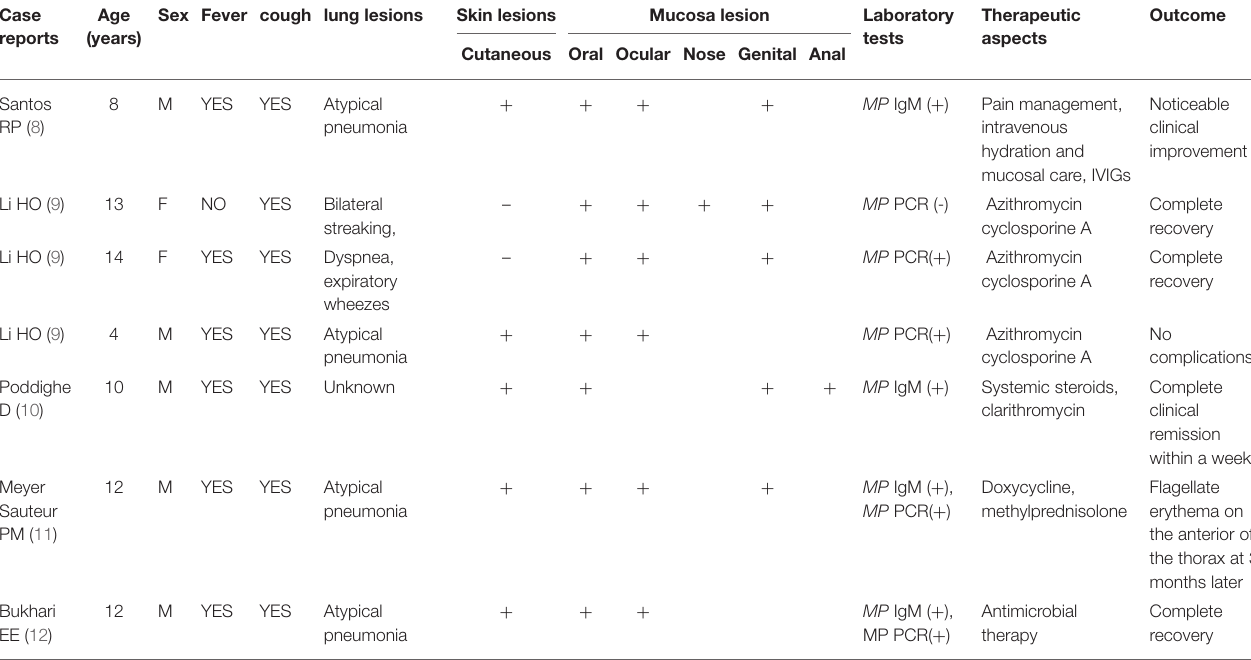
TABLE 4 | Summarizing all the previous cases characteristics of MIRM reported in the medical literature. Case